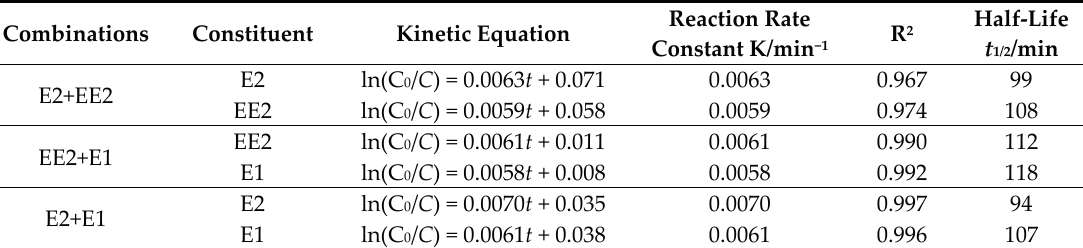
Figure 5. Degradation curves and first order kinetic models of dual- and tri-mixed SEs in the combination process. Table 4. Parameters of degradation kinetic model of dual-mixed